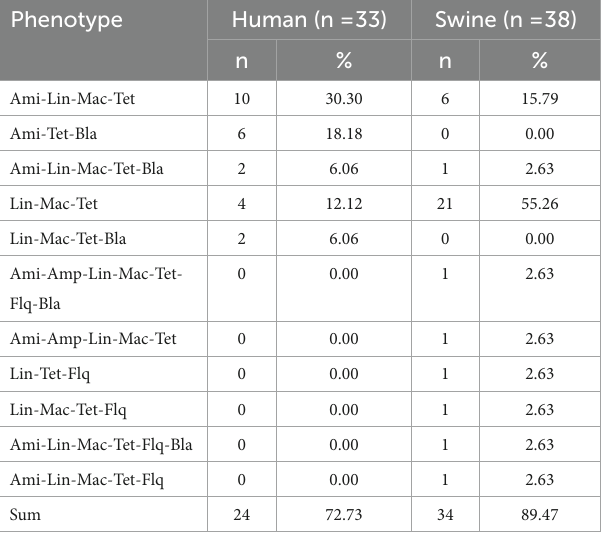
TABLE 1 Phenotypic antimicrobial resistance (AMR) profiles of Streptococcus suis isolated from Shenzhen, China.